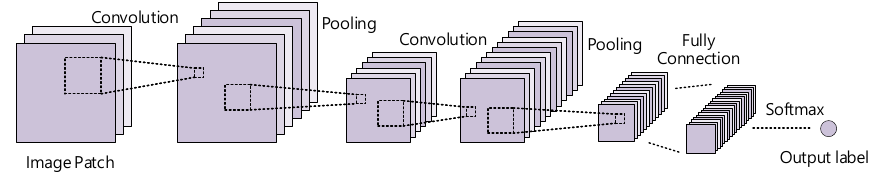
Figure 3. Illustration of typical CNN